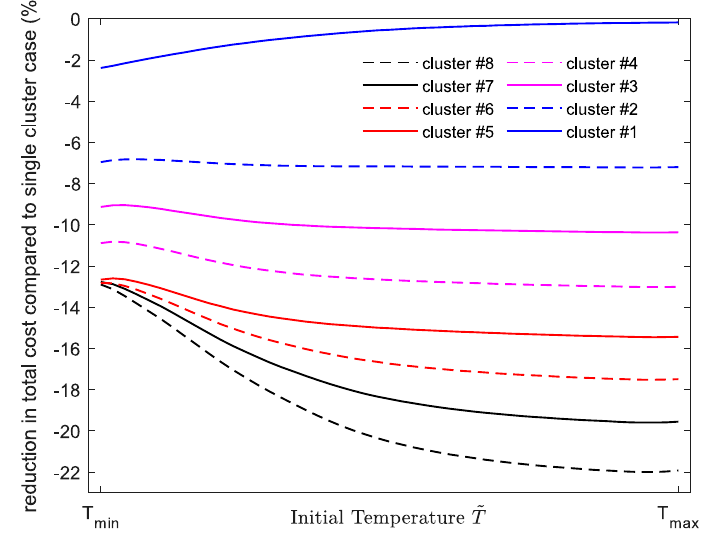
Figure 10. Percentage reduction in total cost for individual TCLs in different clusters compared to the total cost sustained when C = 1 (Base Case (BC) assumptions).